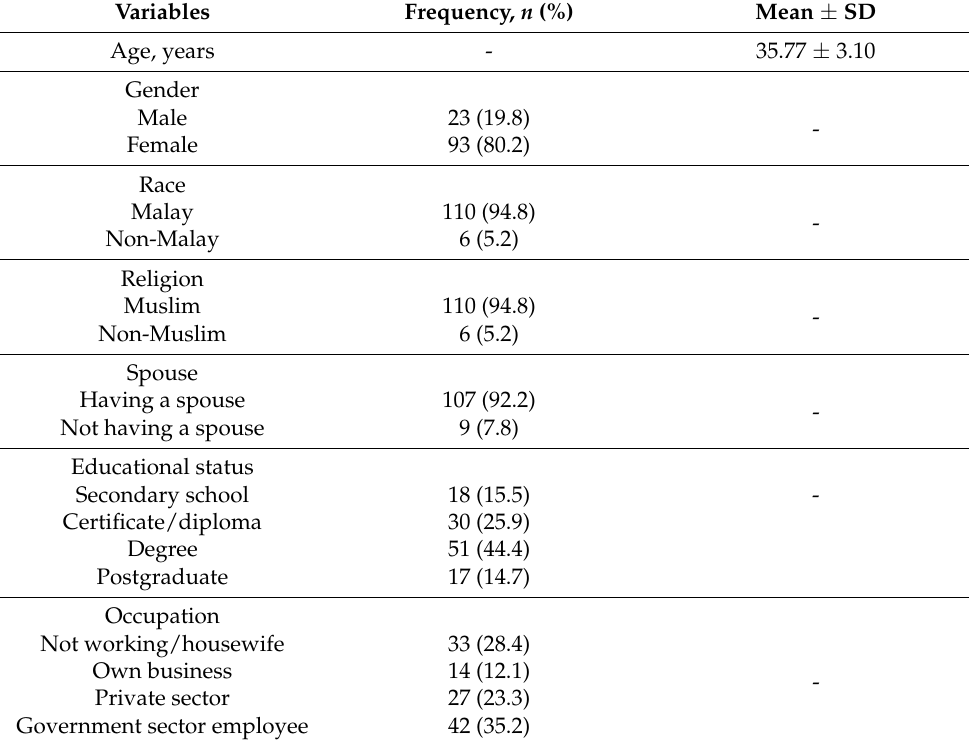
Table 1. Sociodemographic and clinical characteristics of the main caregivers ( n =